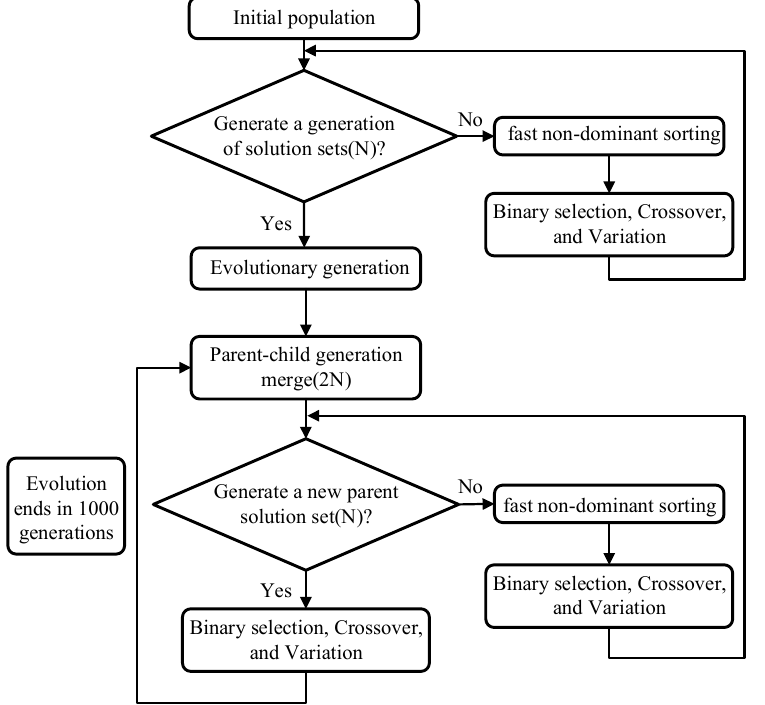
Figure 5. NSGA-II algorithm flowchart.